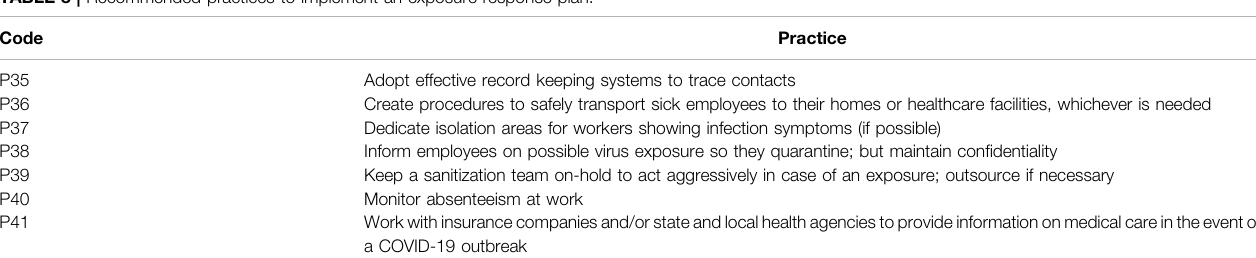
TABLE 8 | Recommended practices to implement an exposure response